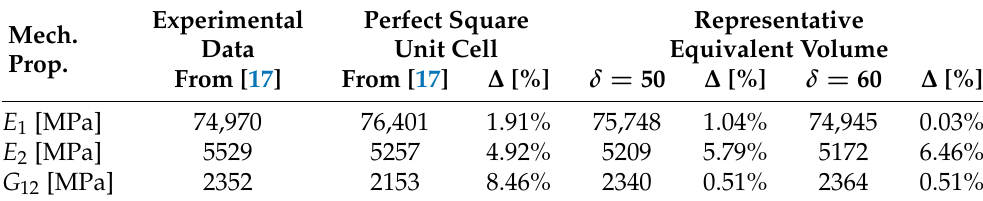
Table 8. Comparison of homogenized elastic properties with experimental data where ∆ = 100 × | ( EXP − HM ) / EXP | with EXP the experimental data and HM the homogenized properties computed for the respective representative equivalent volume